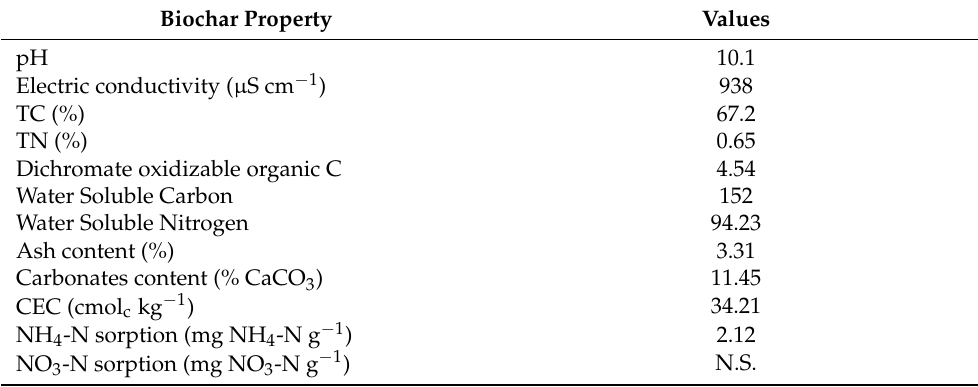
Table 2. Properties of biochar